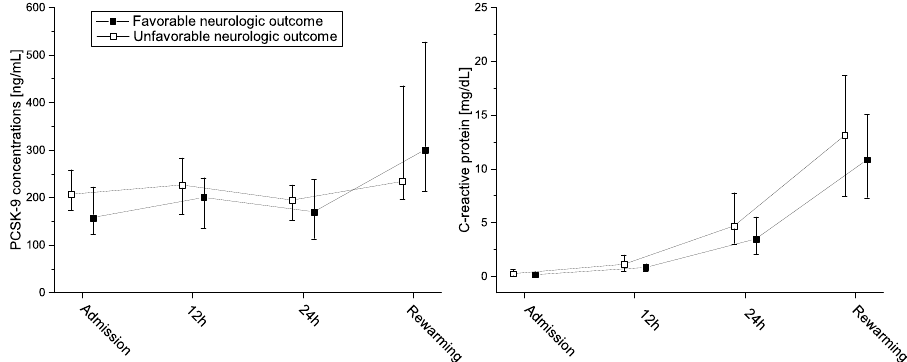
Figure 1. PCSK–9 (left panel) and CRP ‐ levels (right panel) for favorable and unfavorable 30 ‐ day neurologic function . Data are median ± IQR. PCSK–9, proprotein convertase subtilisin/kexin type 9.